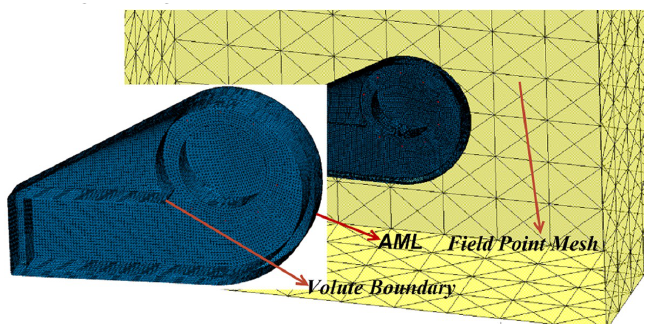
Figure 13. The volute acoustical FEM model.